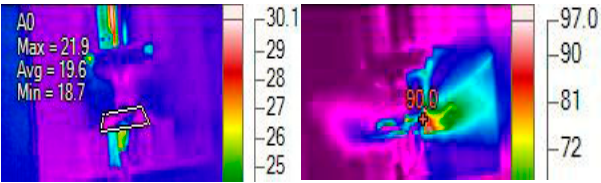
Figure 8. Thermal response of the battery compressed by a rigid rod (unit: degC) at SOC = 0.6.